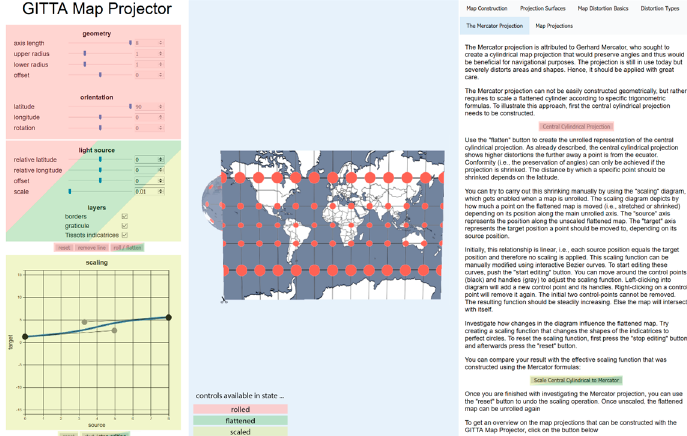
Figure 6. The prototype allowing for an interactive understanding on the construction of map projections. A flattened central cylindrical projection was manually scaled in such a way that the Mercator projection could be approximated. Tissot’s indicatrices were added to visualize the conformity property. Left : user interface elements to explore different configurations of map projections. Center : the three-dimensional (3D) view containing the relevant 3D objects to construct map projections. Right : example page of the tutorial with explanations on the Mercator projection. On the left side, a control panel allows changing the configuration in the 3D view and toggling the transition from one state (see Figure 3) to another. The initial state is “rolled”. The available